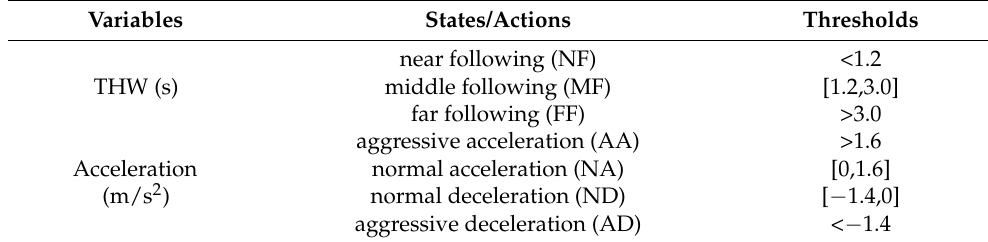
Table 3. Variable thresholds.